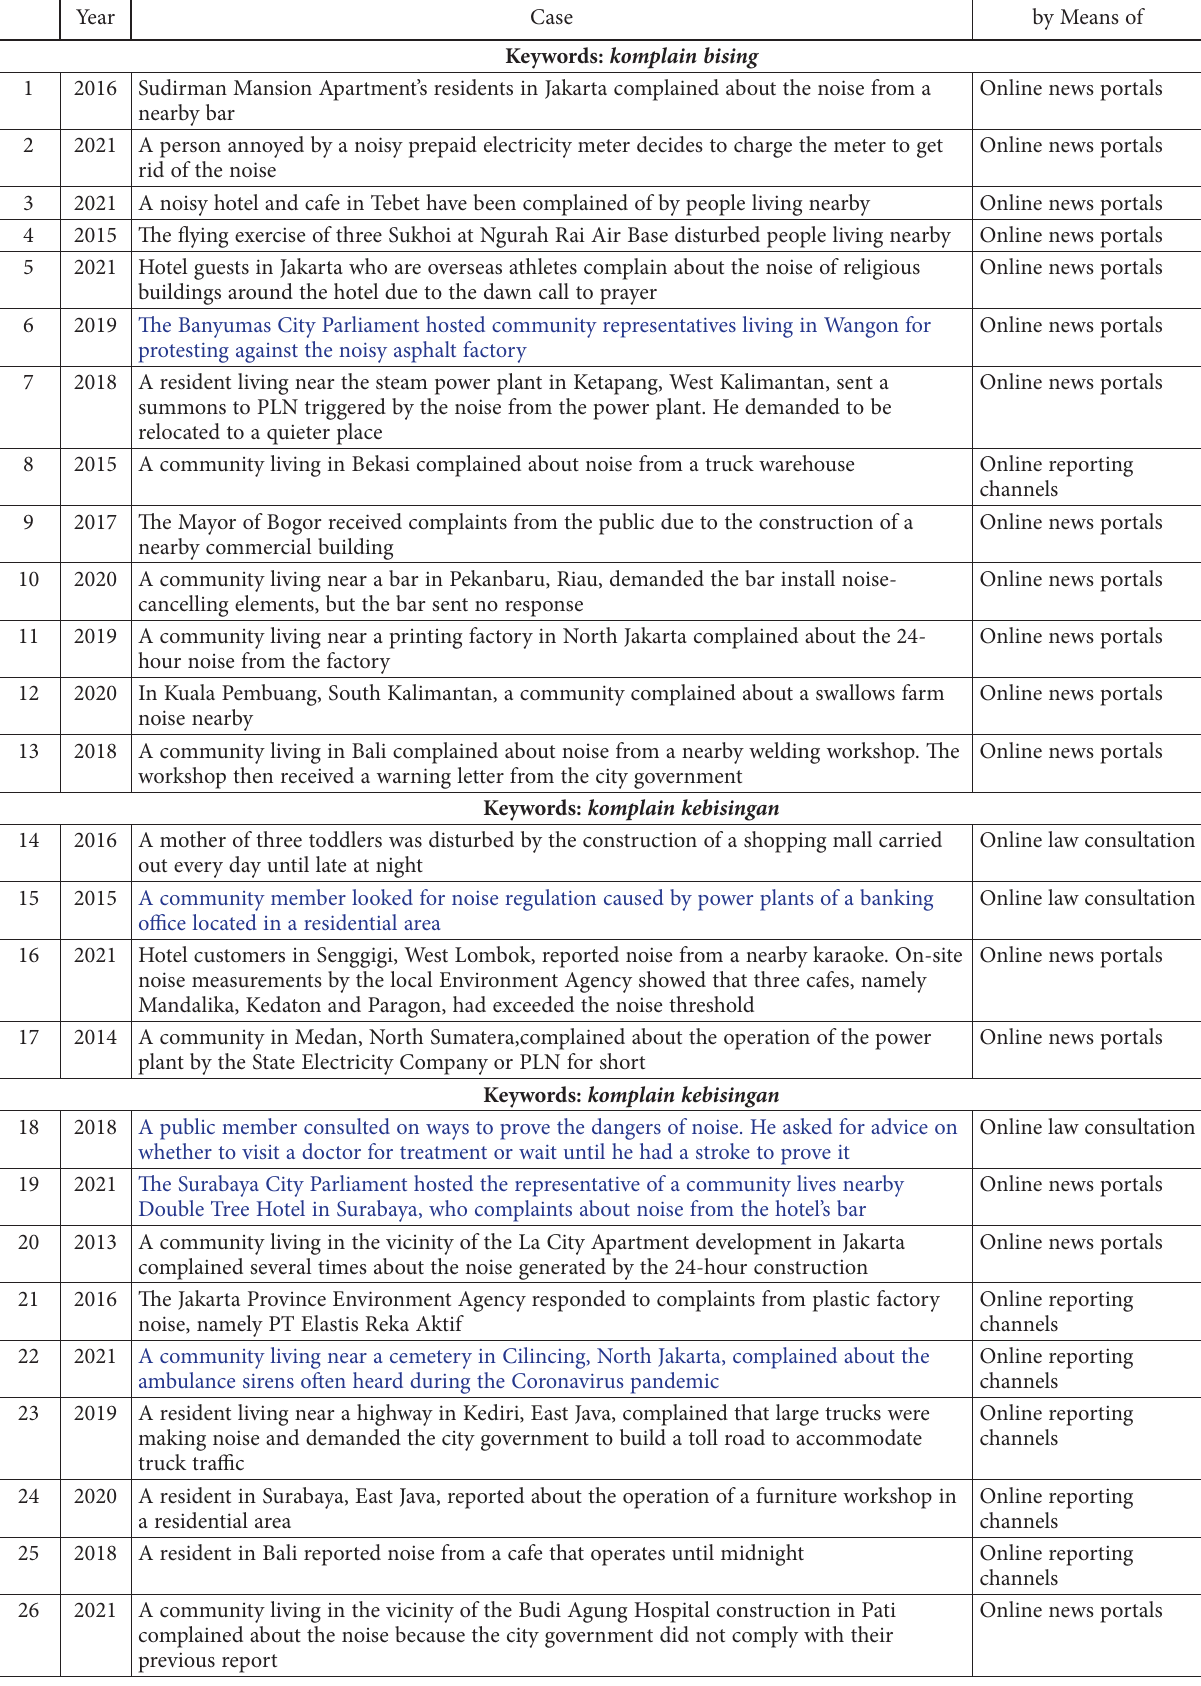
Table 1. Data collected regarding noise complaints from 2008 to